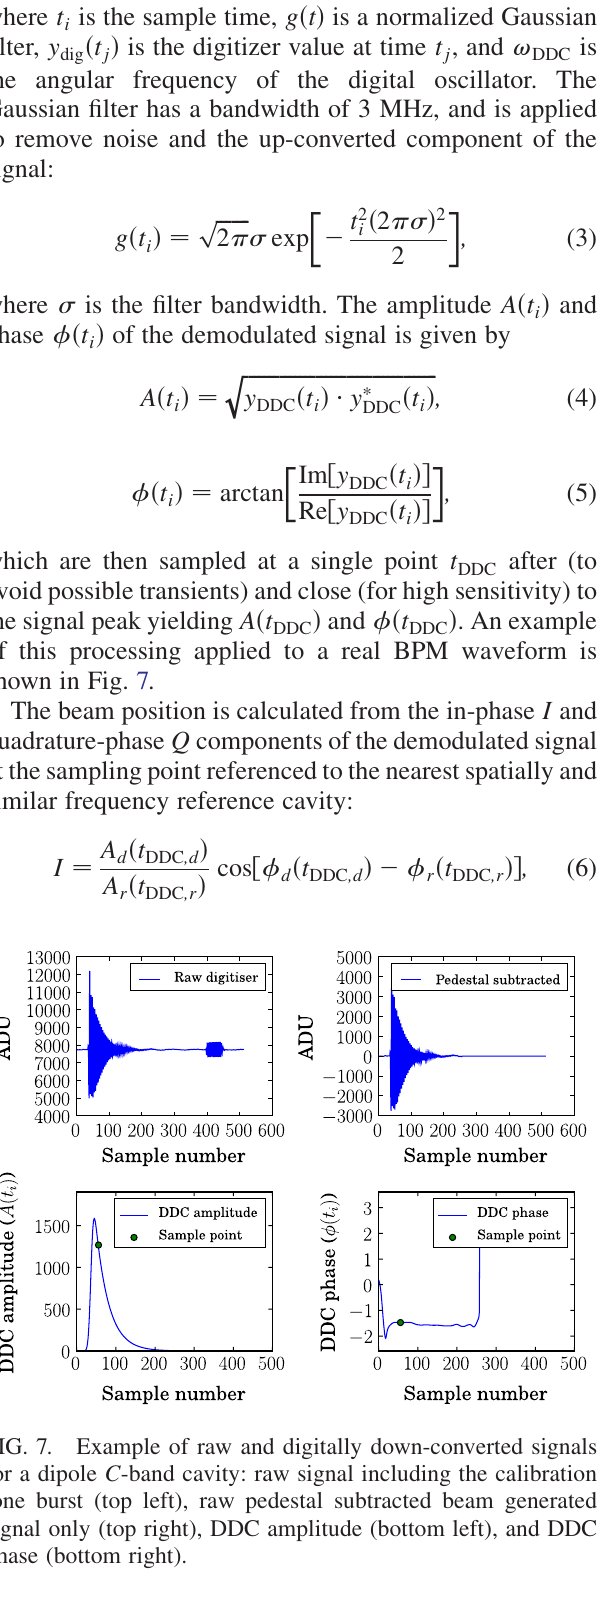
TABLE III. The rf signal processing electronics parameters.